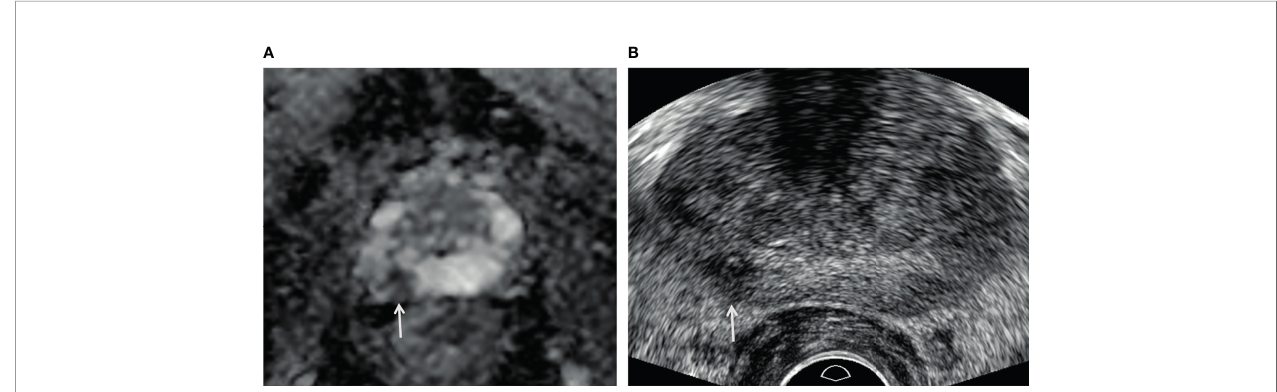
FIGURE 5 | A 73-year-old man with high PSA (3.44 ng/ml). (A) Apparent diffusion coef fi cient map axial image ( b = 1,500 s/mm 2 ) shows a PI-RADS 4 lesion (white arrow) in the right peripheral apex. (B) Transrectal-ultrasound transverse image shows a hypoechoic mass (white arrow) well correlated with that on MRI. Target cores of 1 – 3 and 4 – 6 were sampled from the center and periphery of the index tumor, respectively. Target cores of 1 – 4 and 6 were con fi rmed as GS 6 (3 + 3) adenocarcinoma, but a target core of 5 was GS 7 (3 + 4) adenocarcinoma. A radical prostatectomy specimen demonstrated a fi nal diagnosis of GS 7 (3 + 4) adenocarcinoma.